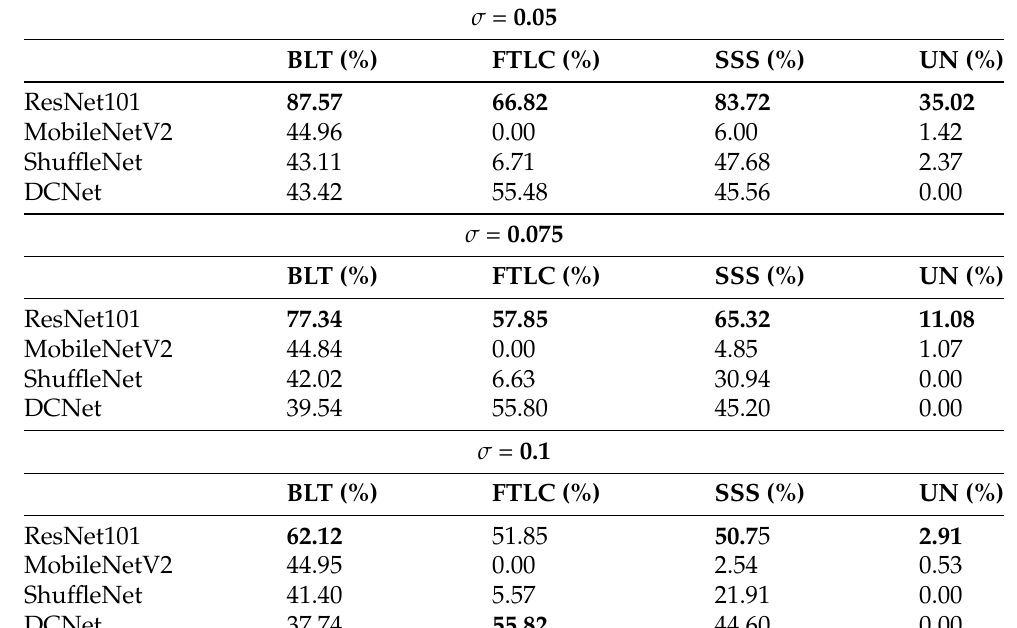
Table 4. Performance of CNN models on different types of degradation and additional speckle noise (in F-measure). Bold fonts indicate the best results.